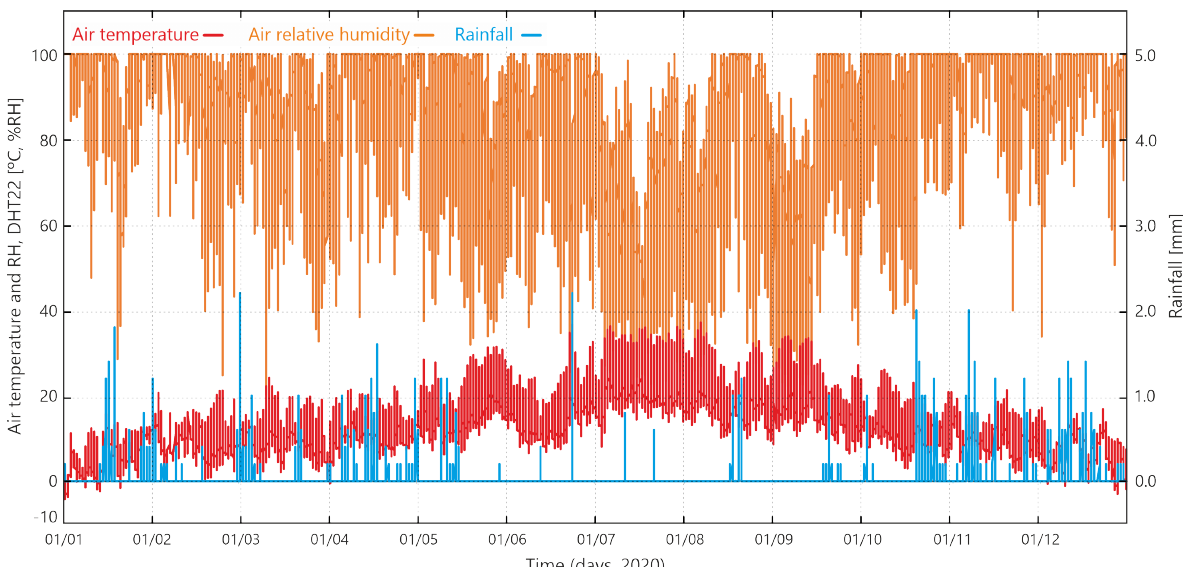
Figure 6. SPWAS’21 Sample data taken during whole 2020, 15 min sampling interval (Air temperature, red; relative humidity, orange; rainfall,